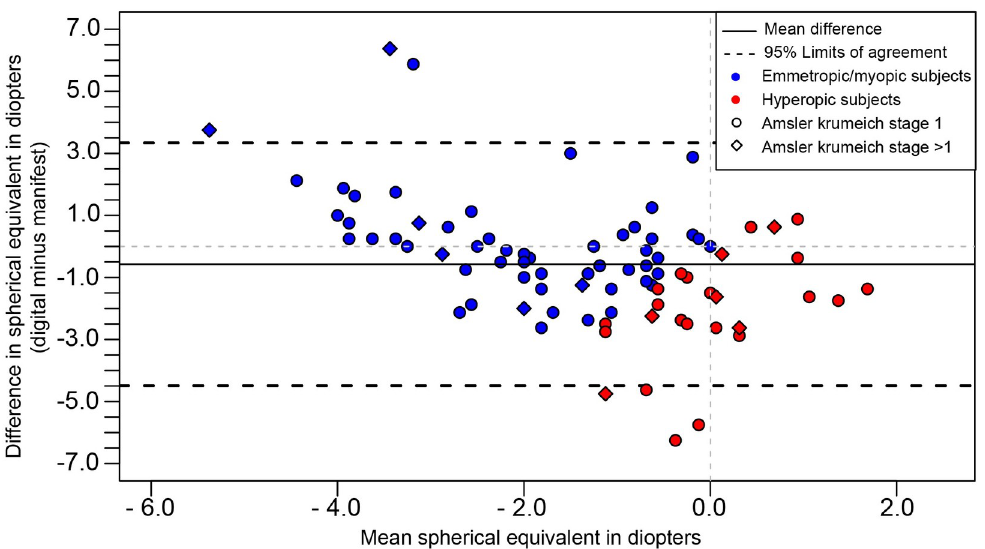
Fig 3. A Bland-Altman plot displaying the differences in refractive error between the web-based refractive assessment (index test) and the manifest refraction (reference test). The difference between the reference and index test shown on the Y-axis is expressed as the difference of the web-based refractive assessment outcome compared to the manifest refraction. The x-axis shows the mean spherical equivalent of the two assessments. Myopia and hyperopia were based on the spherical equivalent of the manifest